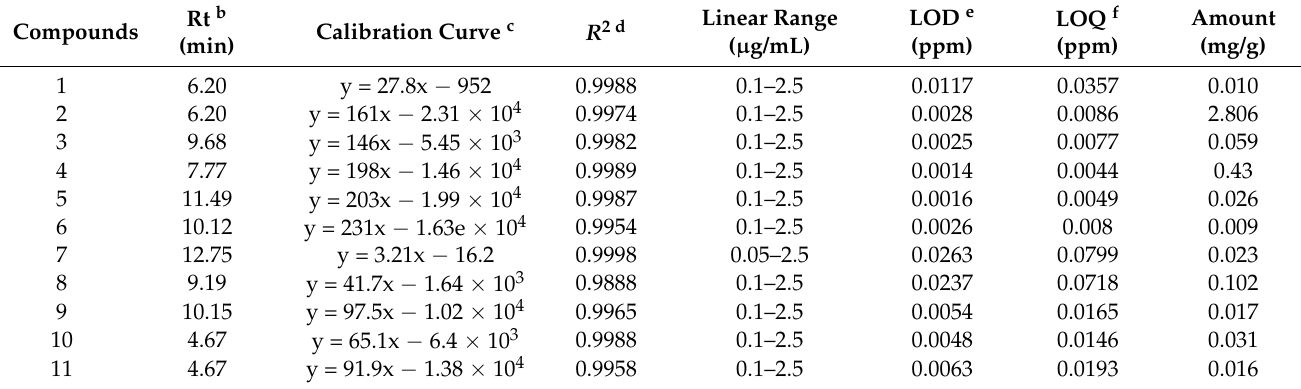
Table 5. Quantification, linear range, regression equation, coefficient of determination LOD and LOQ for LC–MS/MS MRM analysis of compounds 1 – 11 a